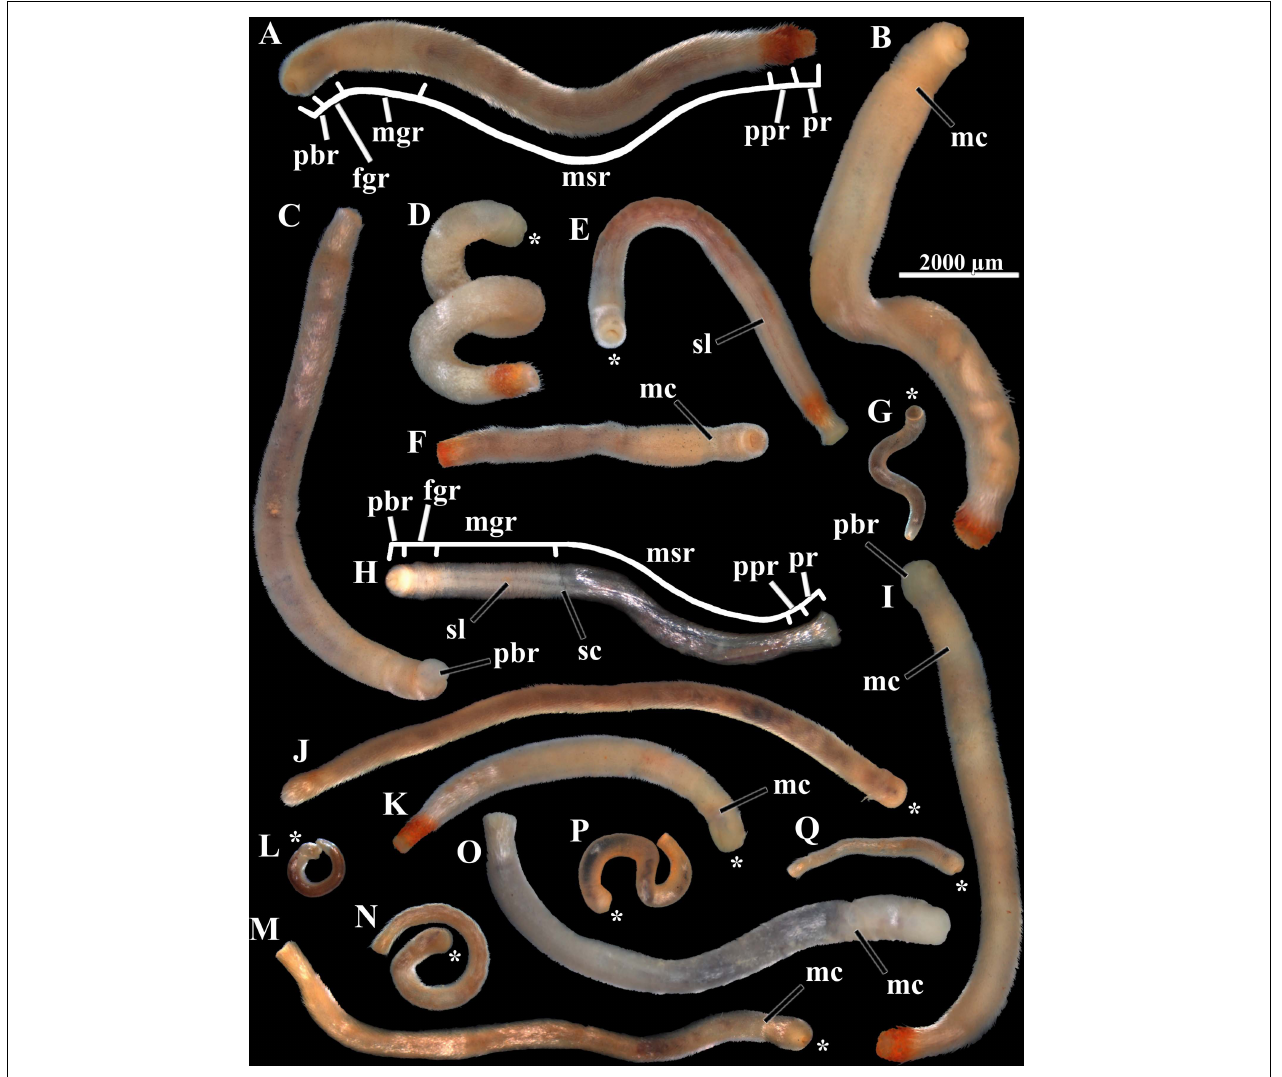
FIGURE 1 | Scutopus variabilis sp. nov. Photomicrographs under stereomicroscope of specimens of different sizes showing their variable body form and color (all in same scale). The body regions are shown in (A) (holotype) and (H) , (B) and (D) had their soft parts dissolved for the extraction of their radulas [which are shown in Figures 4A,E , respectively and of their sclerites from the different body regions. The peribuccal region is protruded in (C) and (I) . The midventral suture line is visible in (E) and (H) ; the main collar in (B) , (F) , (I) , (K) , (M) , and (O) ; and the secondary collar in (H) . The asterisks in (D) , (E) , (G) , (J–N) , (P) , and (Q) show the anterior end. fgr - foregut region; mc - main collar; mgr - midgut region; msr - midgut sac region; pbr - peribuccal region; ppr - prepallial region; pr - pallial region; sc - secondary collar; sl - midventral suture line. Voucher numbers: (A) – ZUEC APL 277, (B) – ZUEC APL 285, (C) – ZUEC APL 287, (D) – ZUEC APL 284, (E) – ZUEC APL 279, (F) – ZUEC APL 282, (G) – ZUEC APL 306, (H) – ZUEC APL 298, (I) – ZUEC APL 286, (J) – MZSP 154099, (K) – ZUEC APL 286, (L) – ZUEC APL 326, (M) – MNRJ 23638, (N) – ZUEC APL 331, (O) – ZUEC APL 291, (P) – ZUEC APL 311, (Q) – ZUEC APL